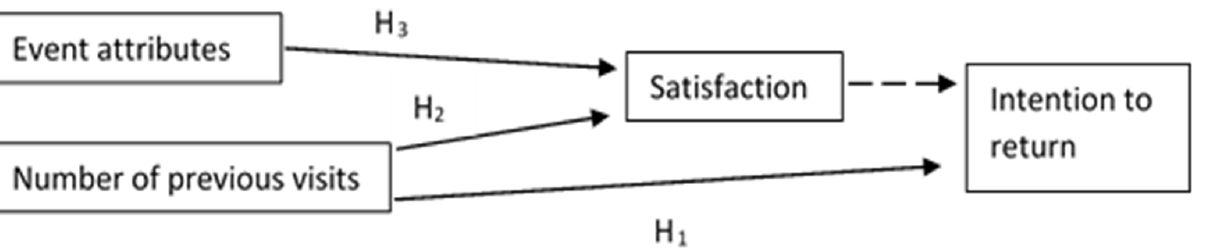
Figure 1. Proposed research